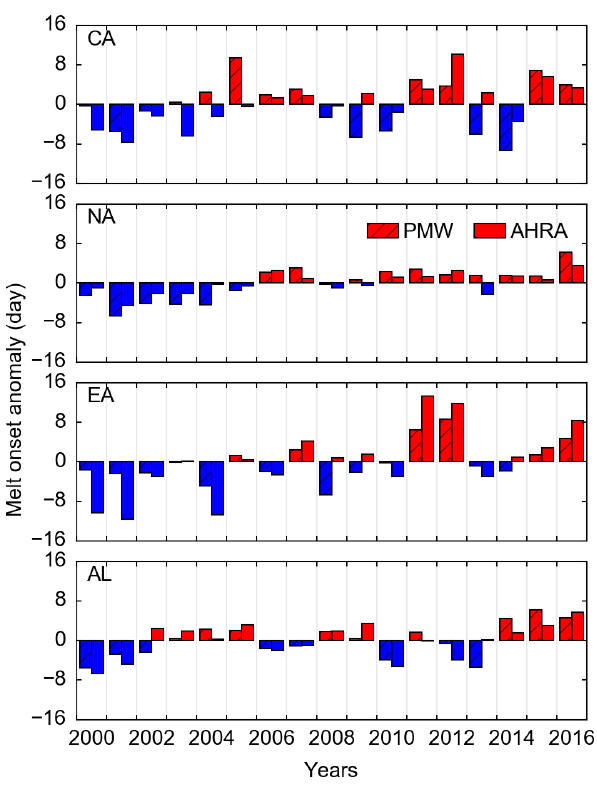
Figure 9. Freeze onset (FO) date for four different Arctic regions using the NASA PMW late-freeze-onset estimates. All data are pre- sented as anomalies relative to the 2000–2016 mean, with a positive (negative) value and red (blue) bars indicating a later (earlier) FO date. The regions (top to bottom) include the central Arctic (CA), North Atlantic (NA), eastern Arctic (EA) and Alaskan (AL) regions shown in Fig.